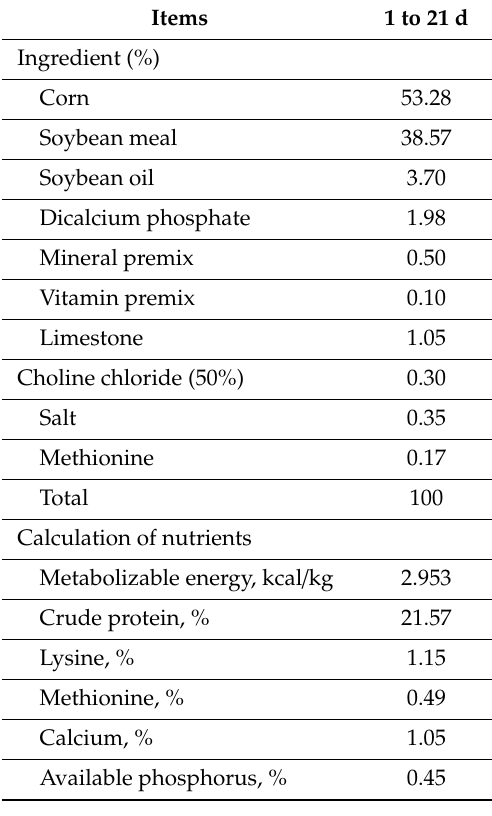
Table 1. Ingredient composition and calculation of ingredients of the basal diet for